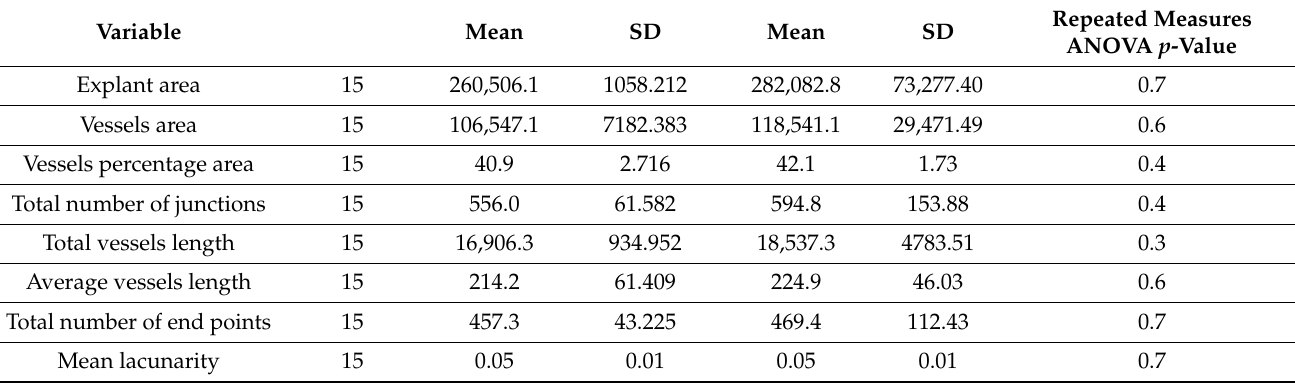
Table 2. OCT angiography parameters at baseline and at the final visit were measured with repeated measures